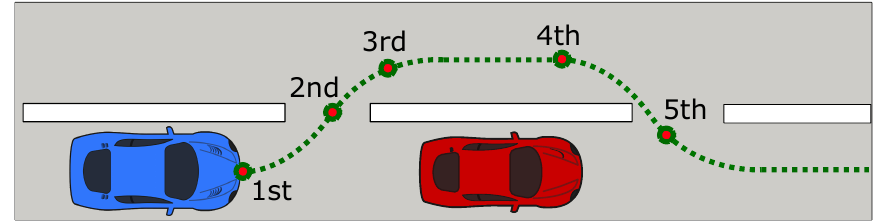
Figure 10. The traffic scenario.